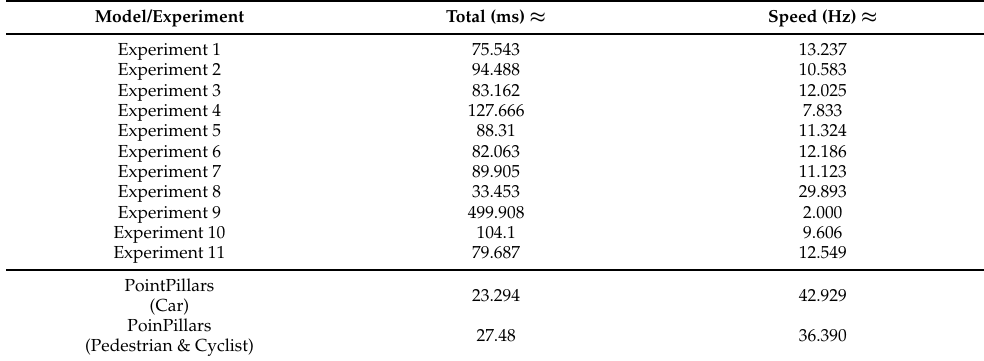
Table 10. Inference time metric benchmark